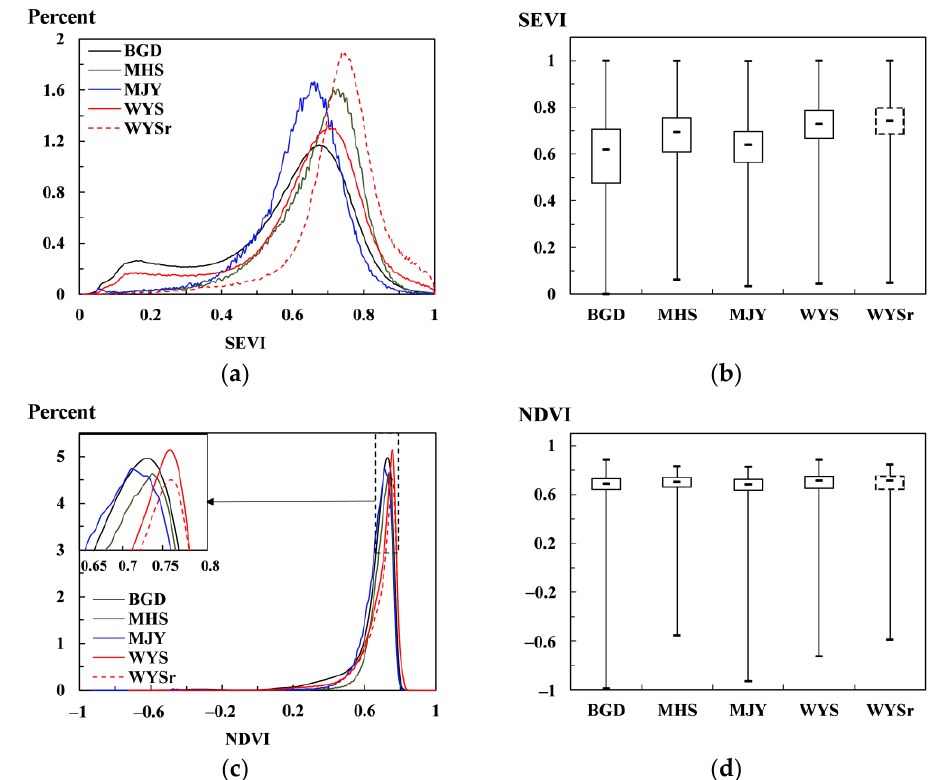
Figure 9. Histogram and box plot of three protected areas (WYSr is Wuyishan National Nature Reserve) and regional background (BGD): ( a ) Histogram of SEVI; ( b ) box plot of SEVI; ( c ) histogram of NDVI; ( d ) box plot of NDVI.